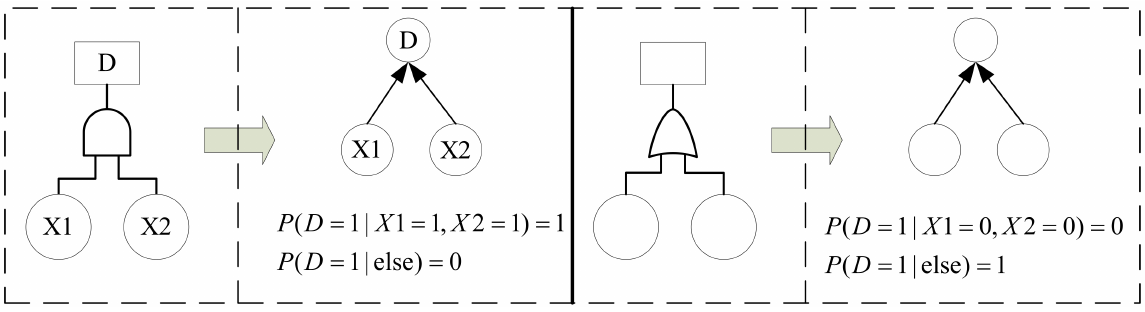
Figure 3. Transformation of fault trees and Bayesian